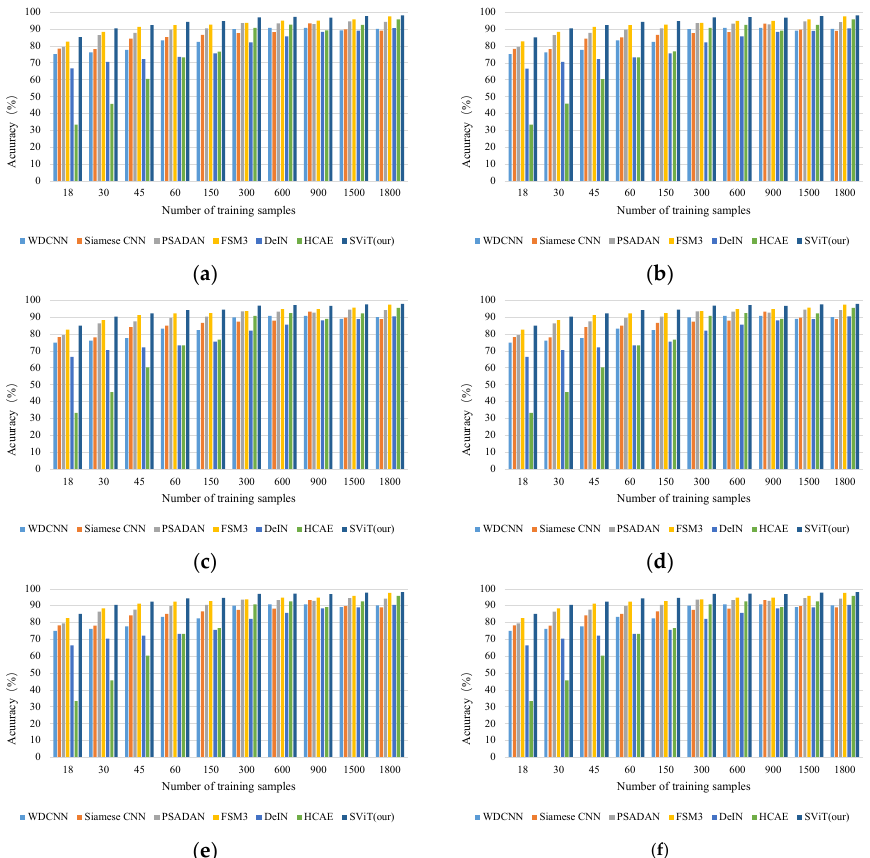
Figure 14. The mean accuracy of cross-domain task with the different number of training samples on the Paderborn dataset. ( a ) D-E; ( b ) D-F; ( c ) E-D; ( d ) E-F; ( e ) F-D; ( f )